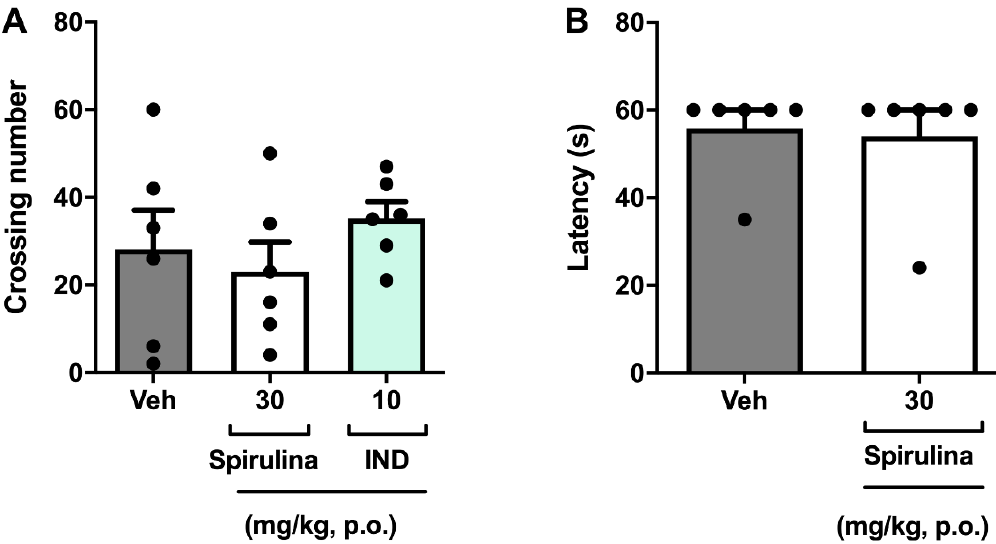
Figure 4. Effect of Spirulina in the open field test (panel A ) and the rotarod test (panel B ). Each column represents the mean ± SEM of 6 animals/group, with a black dot showing individual mice using one-way ANOVA. IND: indomethacin.